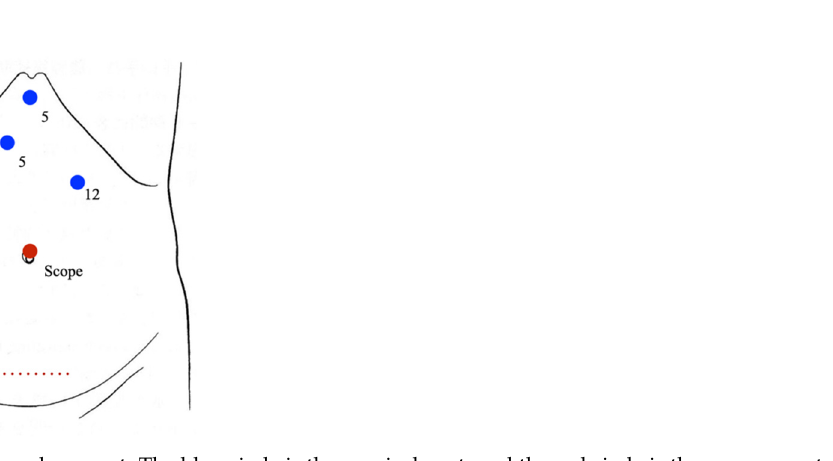
Figure 1. Trocar placement. The blue circle is the surgical port, and the red circle is the camera port. 5 and 12 are port diameters (mm).